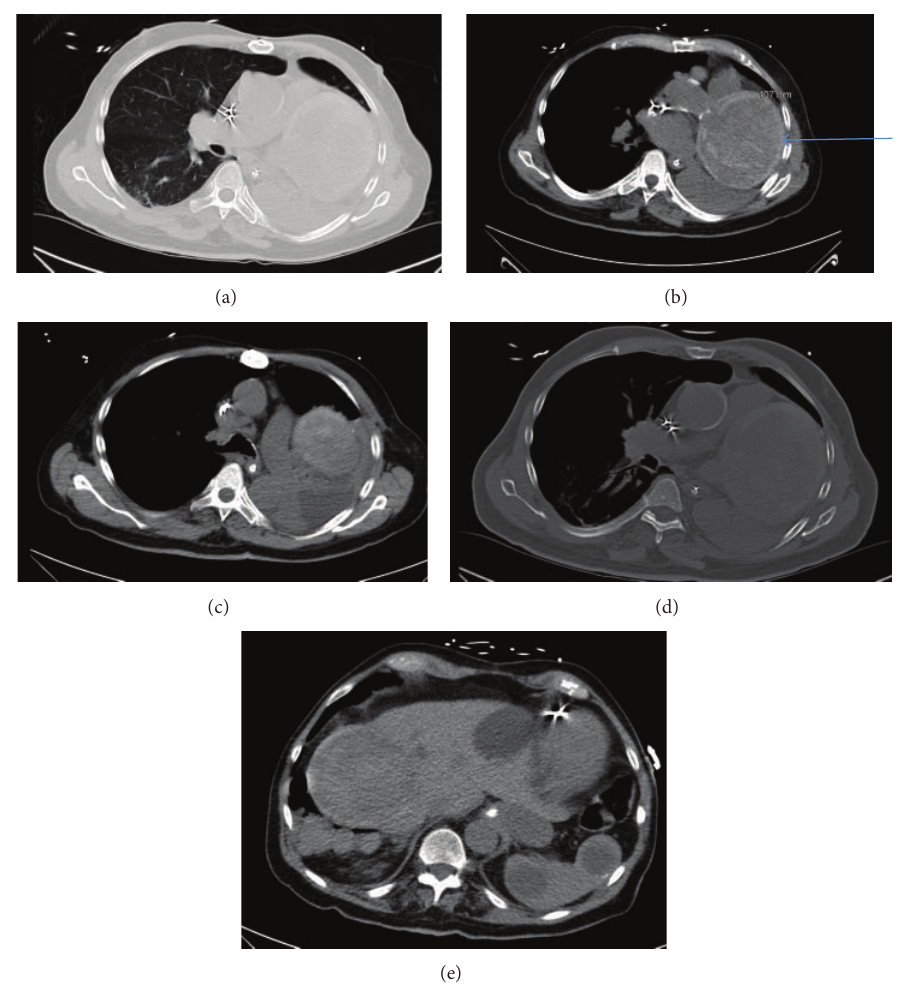
Figure 4: CT of the chest without contrast (March 19, 2014). (a) Left lung volume loss was noted in the left lung with underlying atelectatic change.Amoderatelysizedpleuraleffusionwasnoted,whichcontainedasecondcomponentmeasuringabovethatofsimplefluidattenuation. These findings might represent an element of a hemorrhagic component. It was possible that this was atelectatic lung adjacent to the pleural effusion. An endotracheal tube was seen with the tip in the distal trachea near the carina. Low attenuation material was present within the left main stem bronchus, causing complete occlusion. Atelectatic changes were present in the right lung base with an early consolidation seen. Numerous nodules are seen throughout the lung fields. Scattered small blebs are noted in the right lung. (b) Heart was showing a heterogeneous mass (blue arrow), again noted to be associated with the left atrium and likely arising from the aortic root which measured 9.5 × 11.1cm slightly larger in comparison to the MRA of the chest dated June 10, 2008; at that time it measured 8 cm in maximum diameter. There was a mediastinal shift to the left. (c) A calcified right hilar lymph node was noted. A prominent pretracheal lymph node measured 2 × 1.5 cm and could be a combination of 2 adjacent nodes. This was relatively stable. Another adjacent lymph node was measuring 9.7 cm slightly larger. A few other enlarged lymph nodes in the prevascular space were also present. Examination was difficult due to lack of